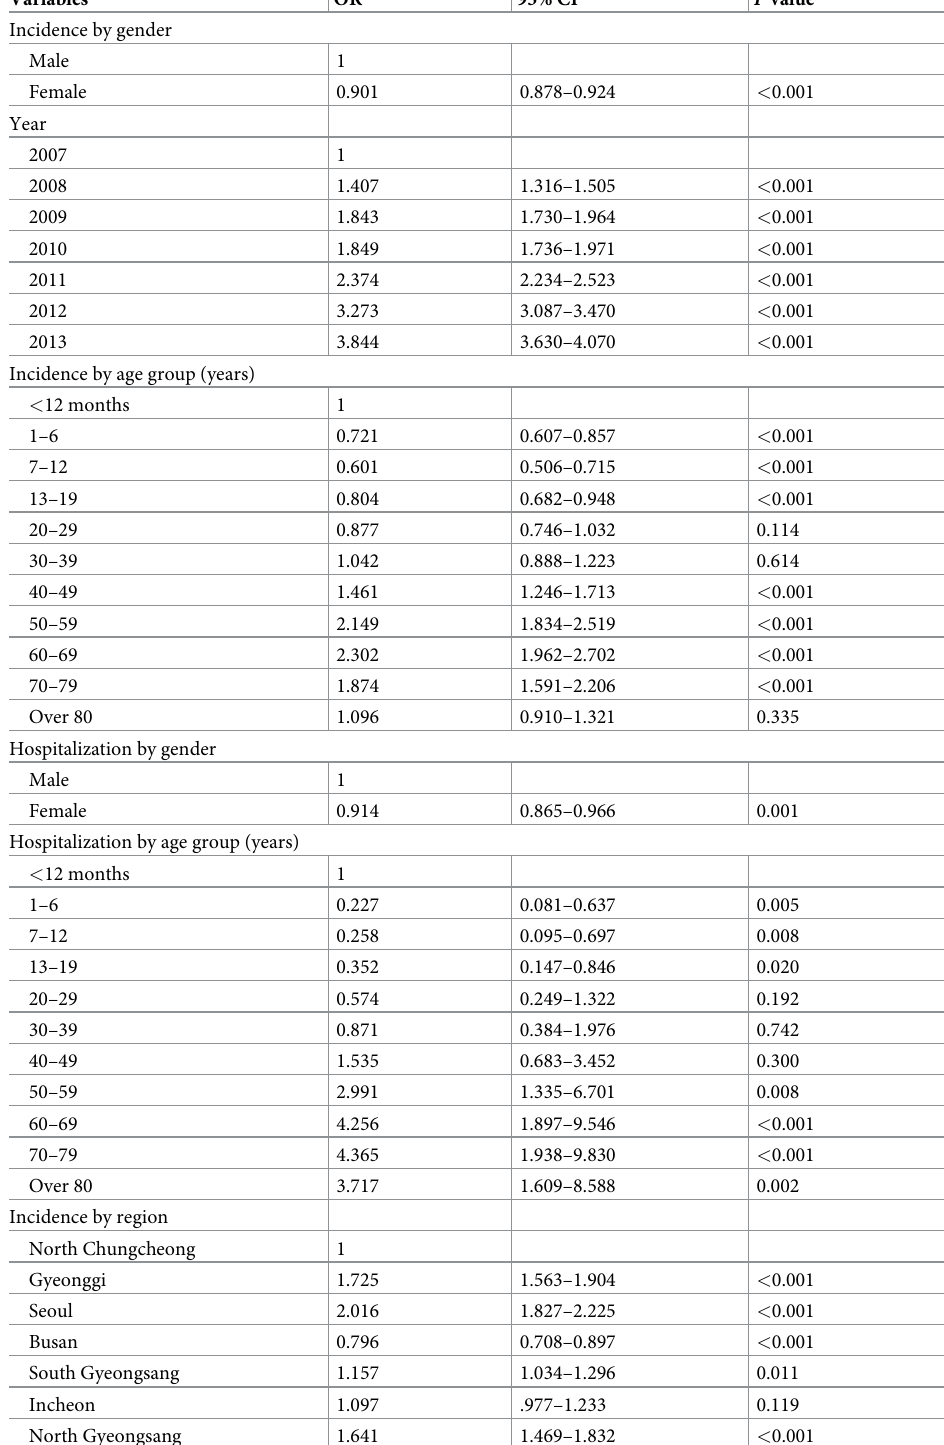
Table 4. The population-based annual risk rate of anaphylaxis visits and intensive care unit (ICU) hospitalization by gender and age-specific